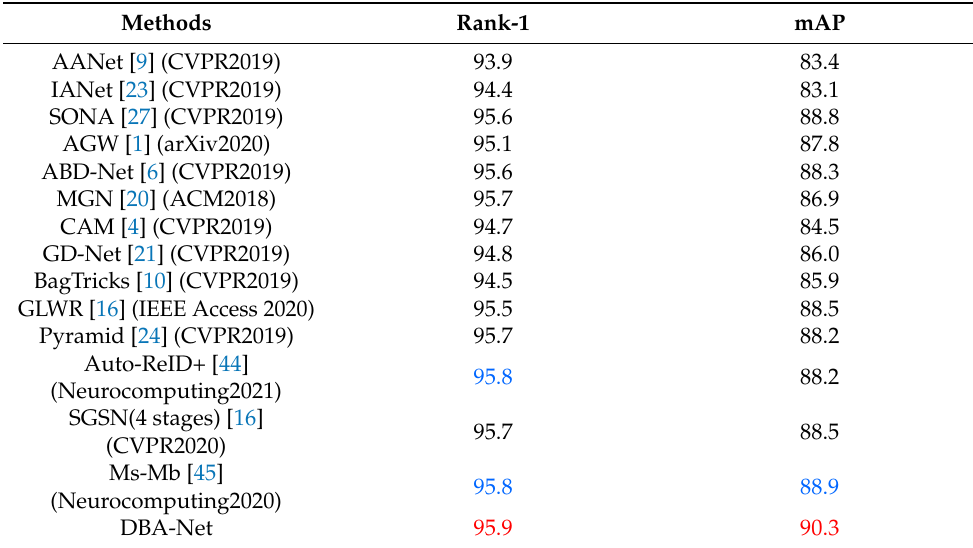
Table 3. Comparison with the SOTA methods on Market-1501. The best performance is shown in red, and the second best performance is shown in